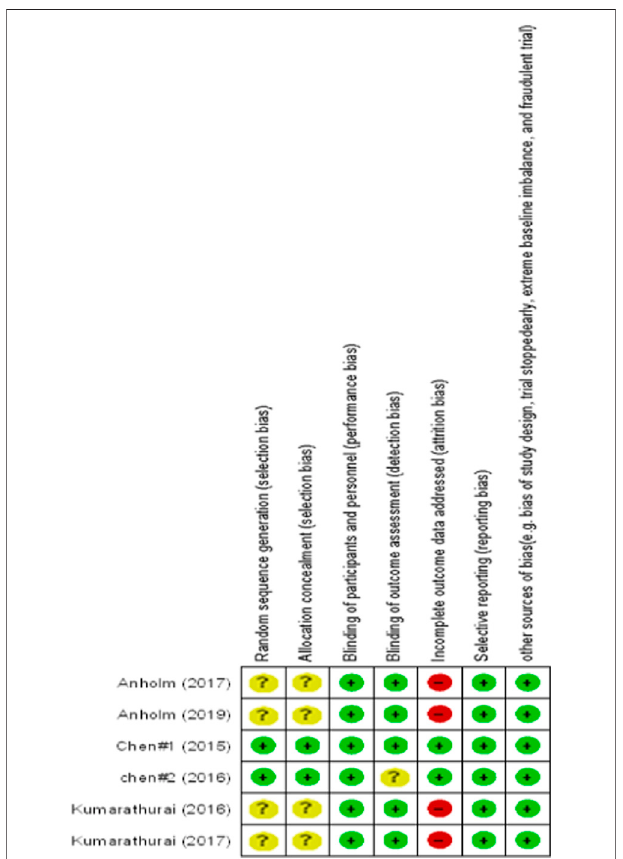
FIGURE 1 | Quality assessment of included